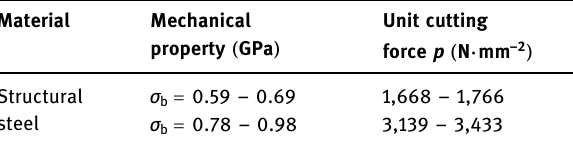
Table 1: Unit cutting force in the gear - shaping process Material